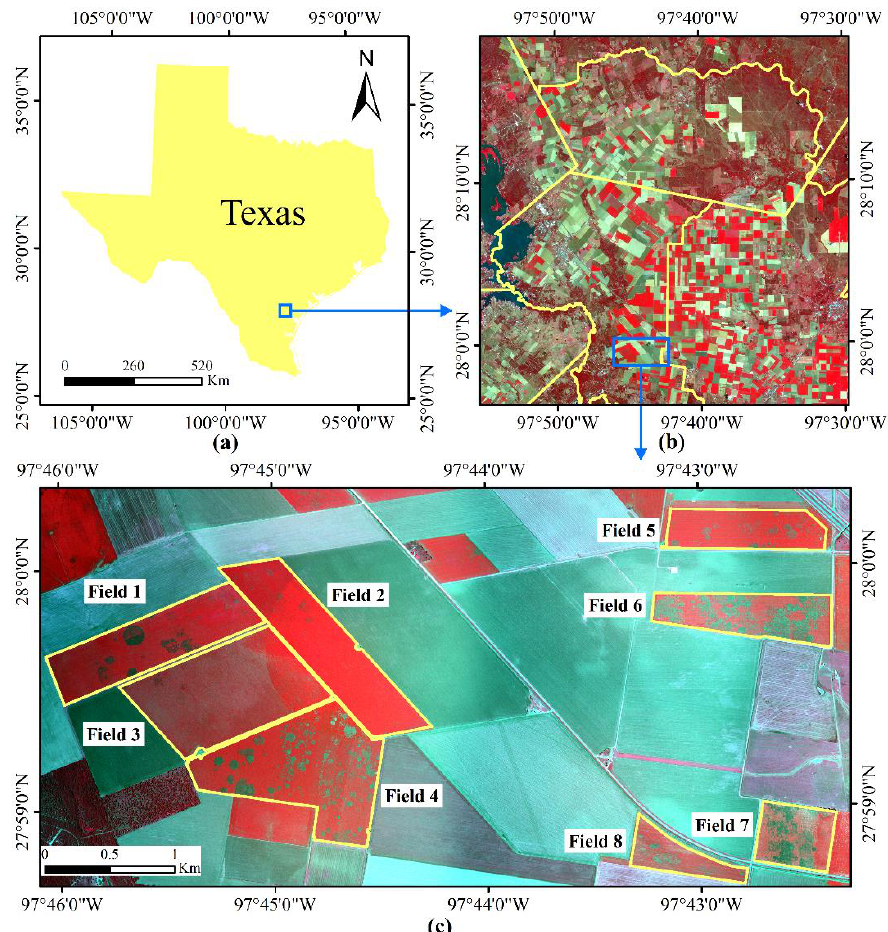
Figure 1. Location of the study area and Sentinel-2 imagery. ( a ) Study site; ( b ) Sentinel-2A color infrared (CIR) composite image; ( c ) Airborne CIR composite image.